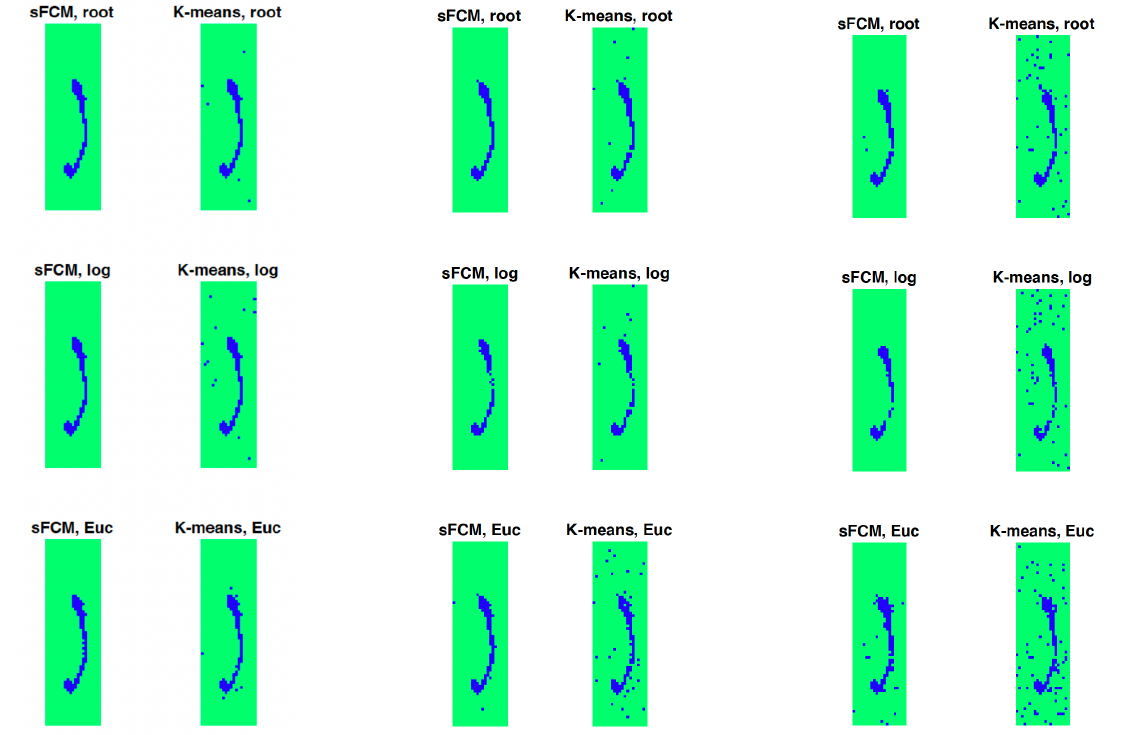
Figure 2. Segmentation after adding three levels of